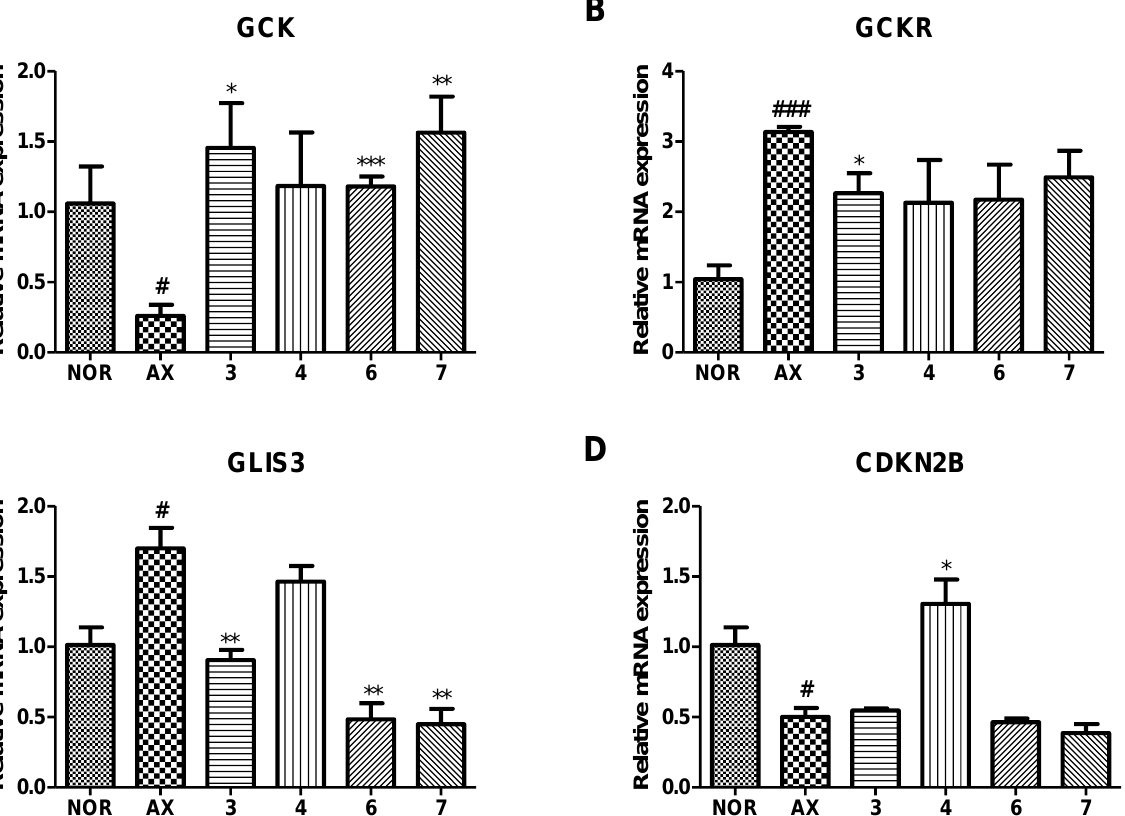
Figure 9. Effect of isolated compounds ( 3 , 4 , 6 and 7 ) on the mRNA expressions of ( A ) GCK , ( B ) GCKR , ( C ) GLIS3 and ( D ) CDKN2B in alloxan-induced zebrafish larvae. Values are expressed as means ± SD (# p < 0.05, ### p < 0.001; compared to NOR) (* p < 0.05, ** p < 0.01, *** p < 0.001; compared to AX); n = 3.